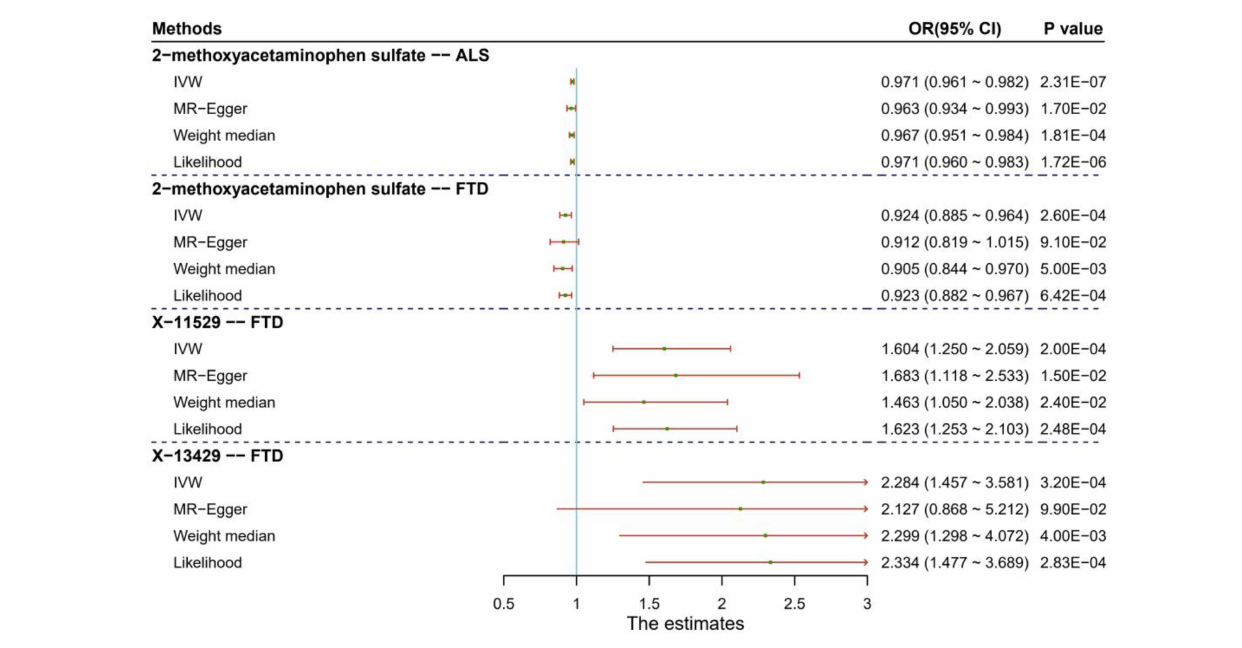
FIGURE 2 | Results of sensitivity analysis for the four significant causal associations identified between human blood metabolites and two types of neurodegenerative diseases (e.g., ALS and FTD). ALS: amyotrophic lateral sclerosis; FTD: frontotemporal dementia.